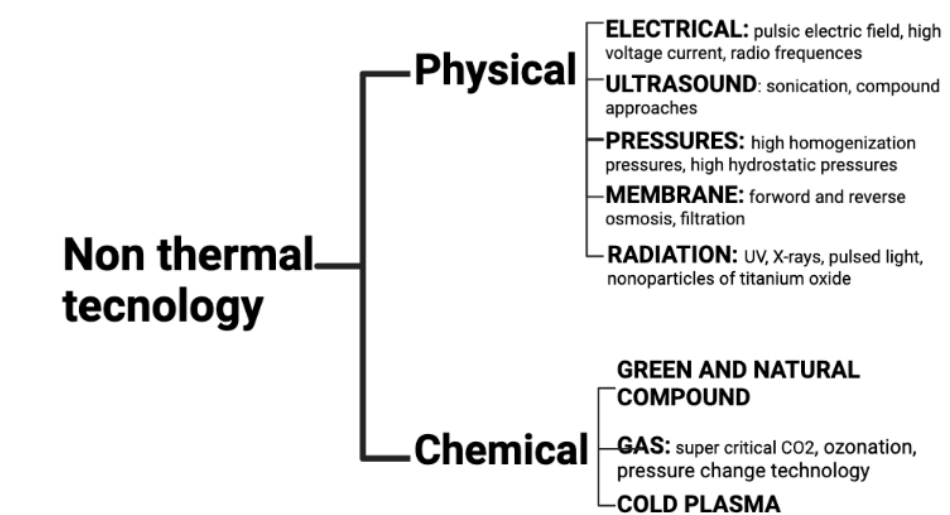
Figure 1. Overview of non-thermal technologies (created with Biorender.com).